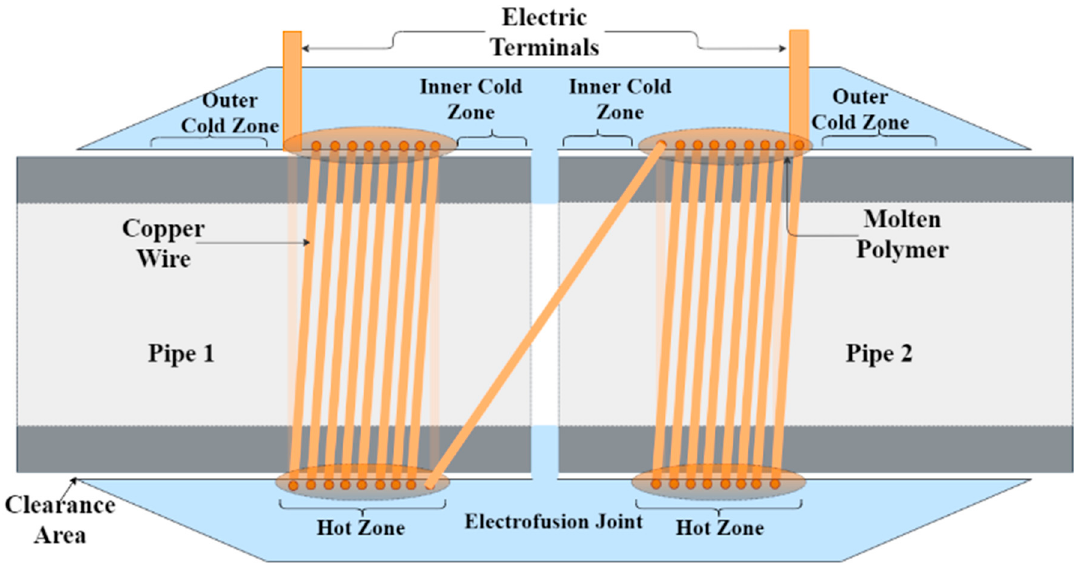
Figure 2. Sketch of an electrofusion joint used in water, gas, sewage, chemical, and nuclear plants.